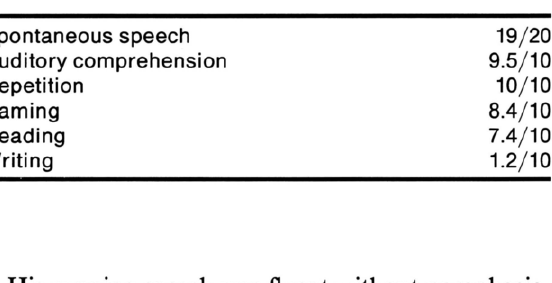
TABLE I. The patient's scores in the subtests in the Western Aphasia Battery